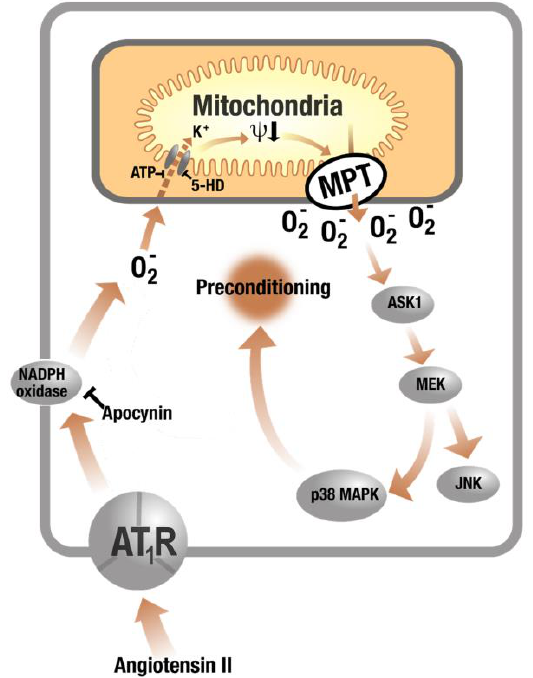
Figure 3. Cross Talk of NOX and mitochondria in AT-II-triggered ROS formation. AT-II-triggered activation of NOX in the cytoplasmic membrane with subsequent opening of mitochondrial K ATP channels by NOX-derived ROS and mitochondrial ROS release via mPTP opening (in the figure termed MPT). Upon mtK ATP opening, the electrophoretic influx of potassium cations into the matrix causes depolarization of the mitochondrial membrane ( ∆ ψ m ↓ ) along with matrix swelling and alkalinization [131]. Matrix alkalinization, in turn, has been suggested to be responsible for the increase in H 2 O 2 formation observed in cardiomyocytes treated with the mtK ATP opener diazoxide [132–134]. The entire process was blocked by the specific mtK ATP inhibitor 5-hydroxydecanoate (5-HD). This concept provides an amplification mechanism for AT-II-induced oxidative stress and contribute to AT-II-mediated preconditioning via P38 mitogen-activated protein kinases (p38 MAPK) and c-Jun N-terminal kinase (JNK) pathway. AT 1 R, angiotensin II type 1 receptor. Modified from [123] and adapted from [92] with permission.